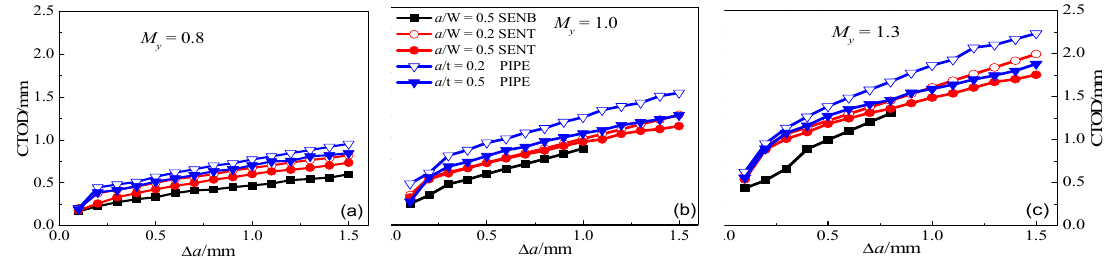
Figure 11. Comparisons of resistance curves for SENB, SENT and pipe, ( a ) M y = 0.8; ( b ) M y = 1.0; and, ( c ) M y = 1.3.